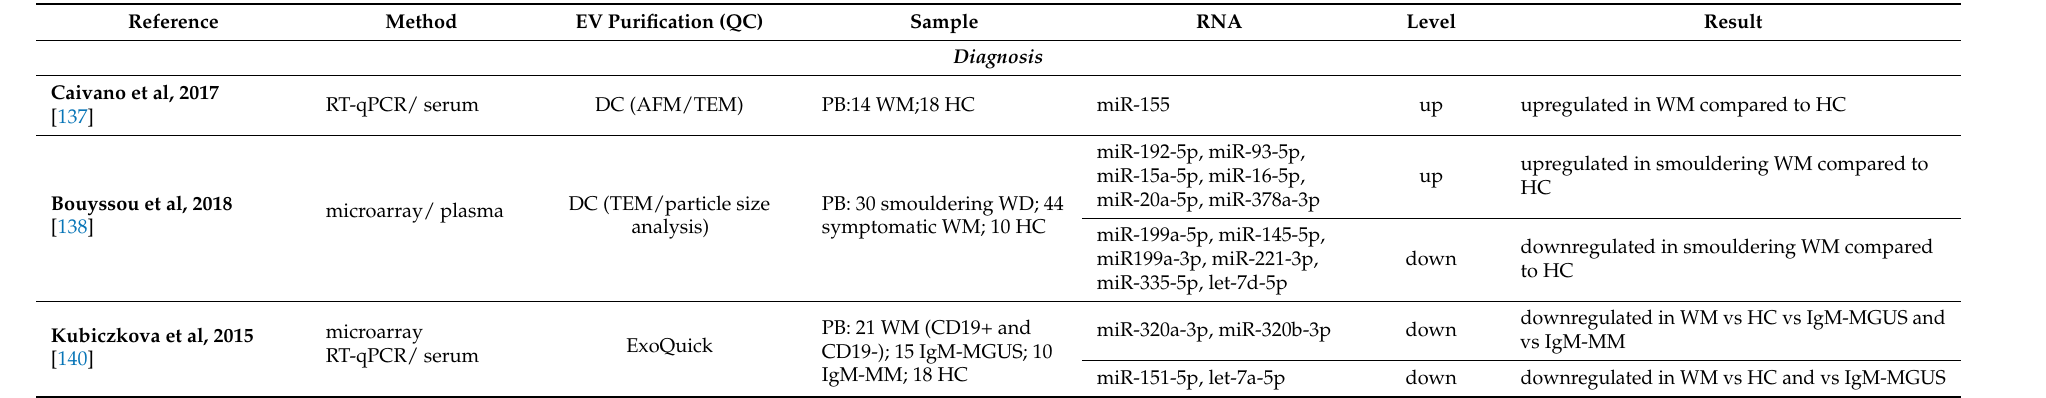
Table 7. miRNA detected in Liquid Biopsy studies in WM. AFM: atomic force microscopy; BM: bone marrow; DC: differential centrifugation; HC: healthy